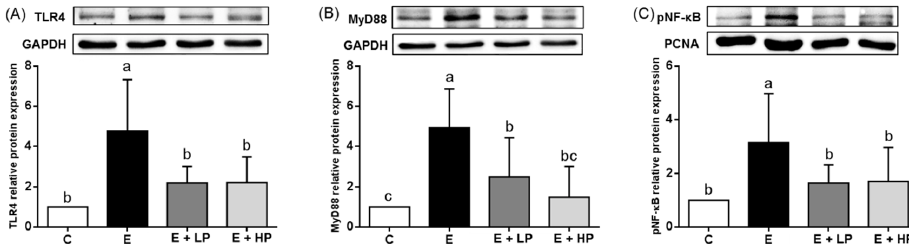
Figure 4. Hepatic ( A ) TLR4, ( B ) MyD88, and ( C ) nuclear pNF- κ B protein expression of mice at the end